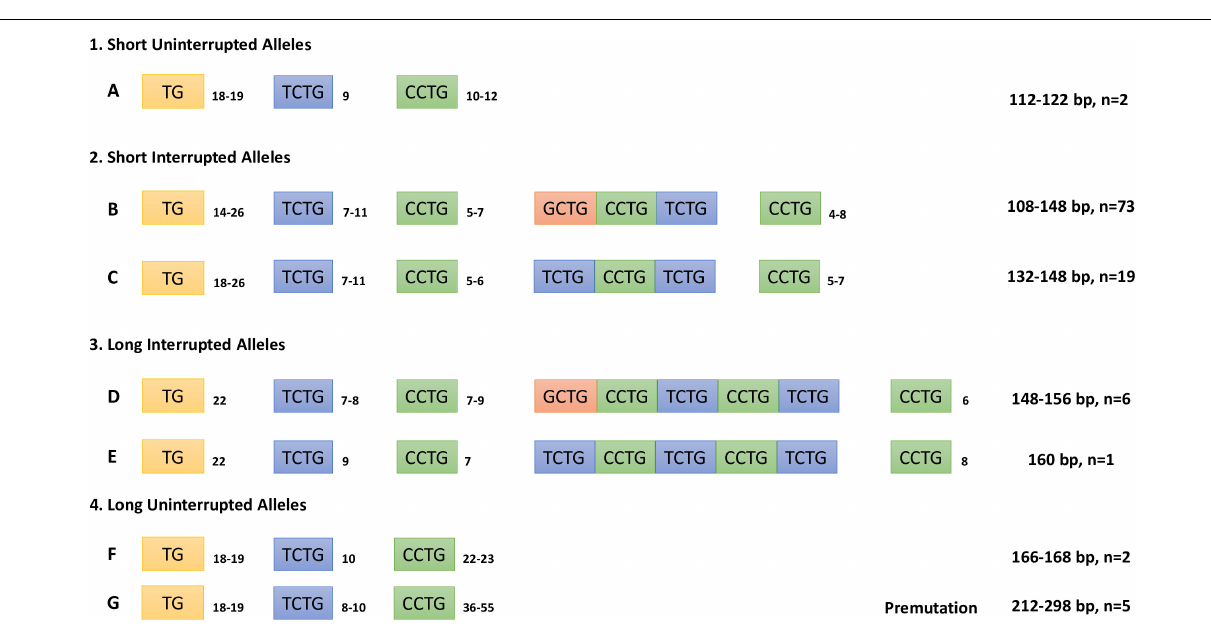
FIGURE 4 | Composition of the combined repeat tract (TG) v (TCTG) w (CCTG) x (NCTG) y (CCTG) z of CNBP non-expanded alleles determined by Sanger sequencing analysis. Repeat tract length in bp and number of alleles characterized are also